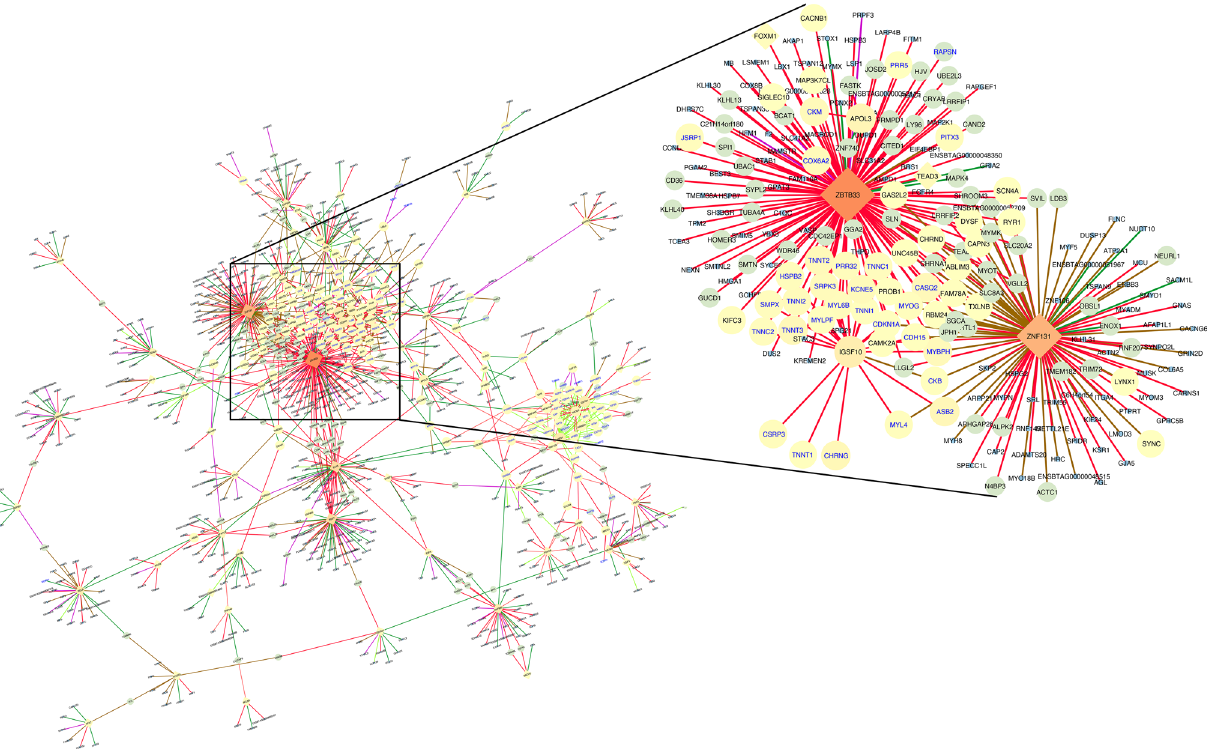
Figure 3. Muscle regulatory network of differentially co-expressed genes from the bovine transcriptome. Nodes are genes with significant changes in the correlation between control and nutrient restricted fetus ( q ≤ 0.05). The node size and color (from light to dark) are proportional to the number of connections for each gene. Nodes with few connections not linked to the main network are not shown. Transcription factors are represented by a diamond shape. Differentially expressed genes are labeled in blue. Edges are colored based on the differential correlation class (+/− , red; +/0, salmon; − /+ , green; − /0, green-yellow; 0/+ , magenta; 0/− , brown). Gene network was created on Cytoscape v.3.7 89